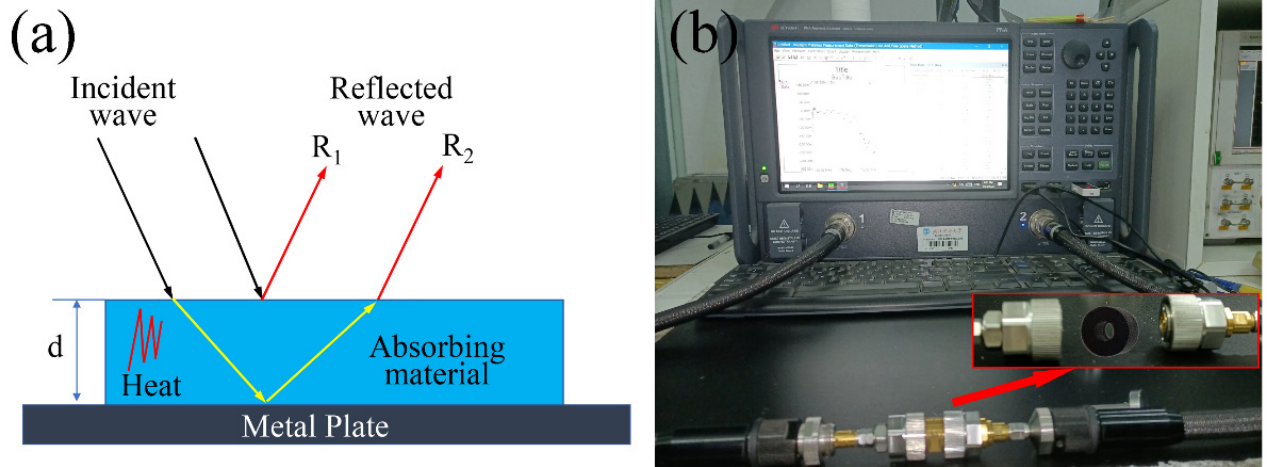
Figure 1. ( a ) The schematic diagram of microwave absorption material. ( b ) Schematic diagram of vector network analyzer and coaxial sample.